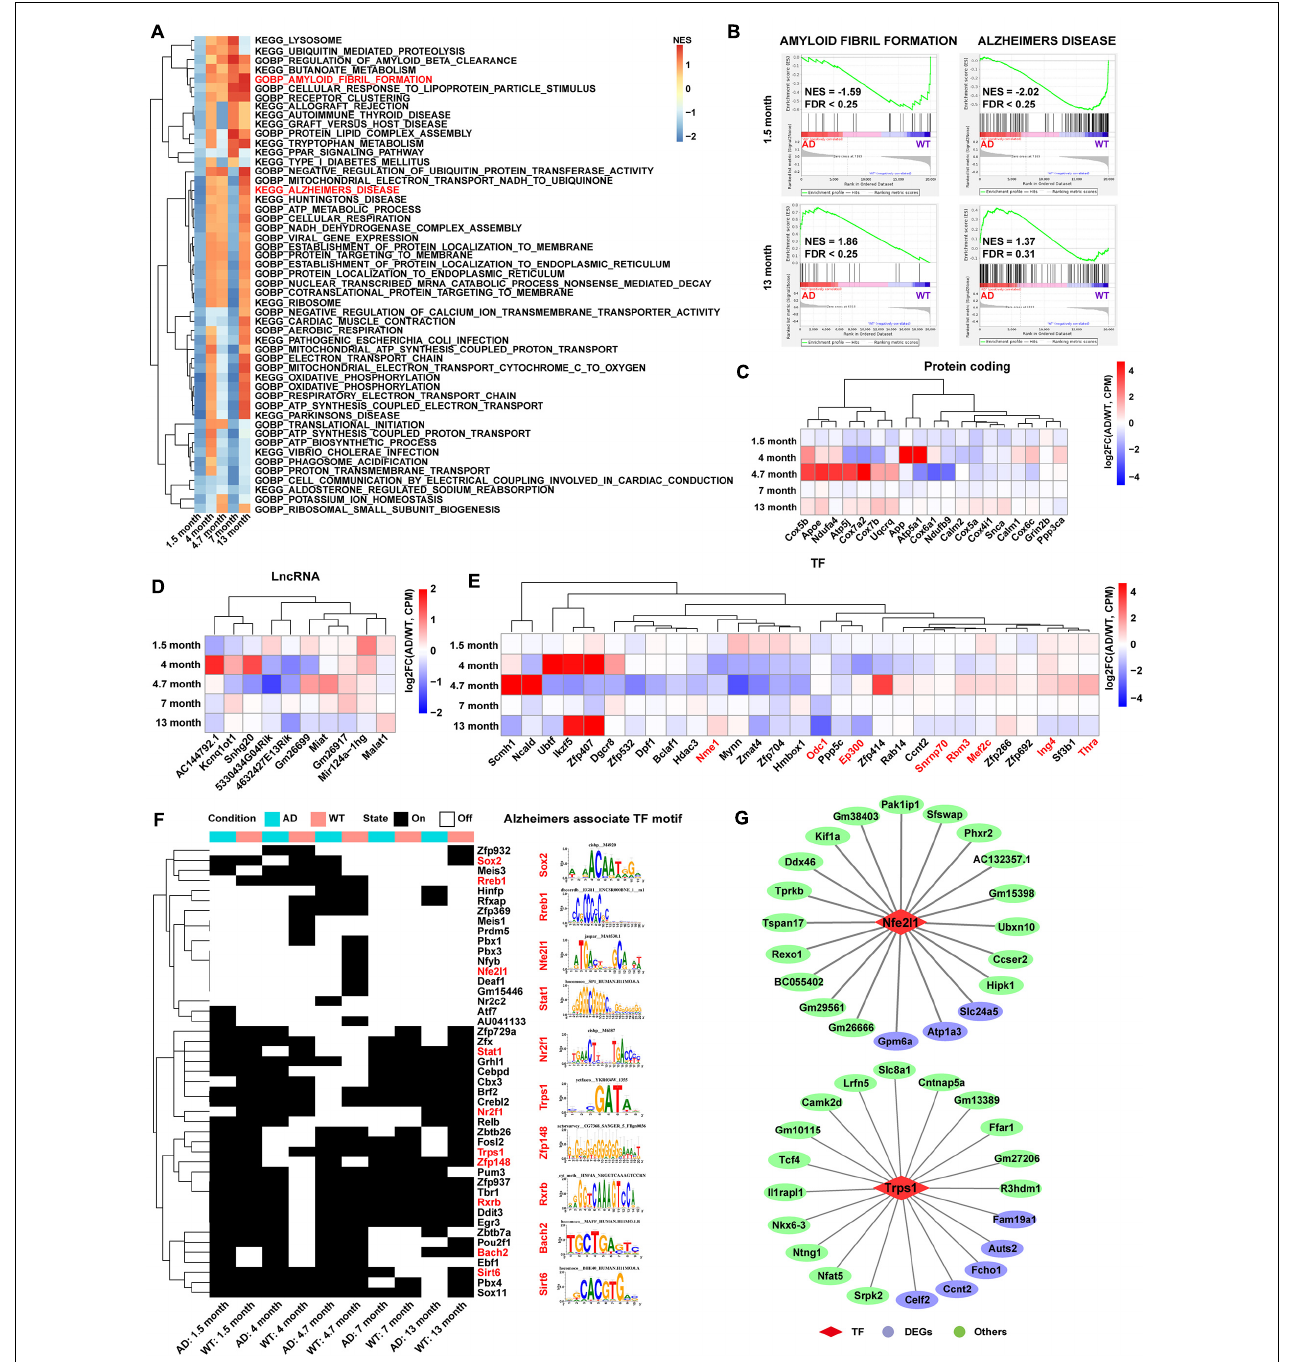
FIGURE 3 | Functional pathway and gene landscape analysis for C3:Ex.Neuron. (A) Heatmap displaying the significantly altered pathways of AD compared with WT excitatory neurons at 1.5, 4, 4.7, 7, and 13 months, as assessed via gene set enrichment analysis (GSEA). The pathways with a false discovery rate (FDR) < 0.25 and normalized enrichment score (NES) > 1 were considered to be significantly enriched. (B) GSEA showing the excitatory neurons involved in AD-related pathways at 1.5 and 13 months. (C–E) Heatmaps showing differential expression of protein-coding genes, lncRNAs, and TFs in AD compared with that in WT mice at different time points in excitatory neurons. Red-colored genes represent Alzheimer’s disease recorded in the molecular signatures (Msigdb) database. (F) SCENIC analysis revealing the switch of TF activity between AD and WT mice in excitatory neurons. The TF motifs with an activity difference in at least one time point were presented. Red-colored TFs represent Alzheimer’s disease recorded in the molecular signatures (Msigdb) database. (G) The network showing the TFs and their target genes in excitatory neurons. AD, Alzheimer’s disease; WT, wild-type; SCENIC, Single-cell regulatory network inference and clustering.